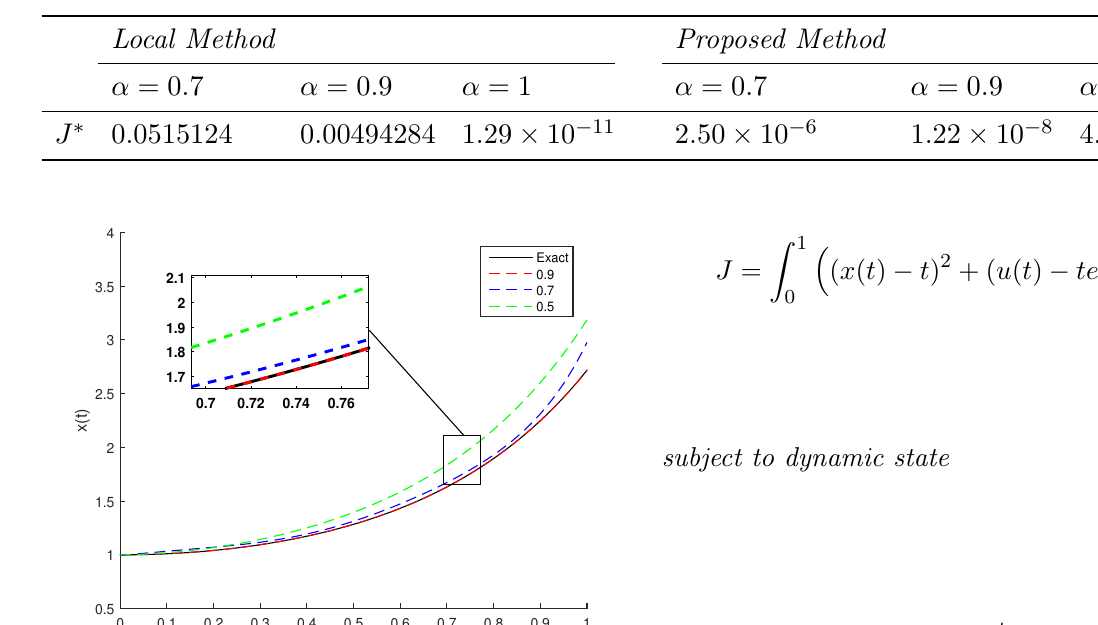
Figure 3. State x ( t ) as a function of t for the Example 2 for m = 7 and different values of α (green: α = 0 . 5, blue: α = 0 . 7, red: α = 0 . 9).